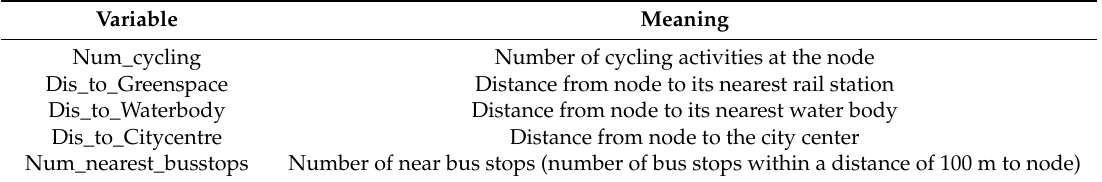
Table 1. Independent variables in the estimation of non-commuting cycling